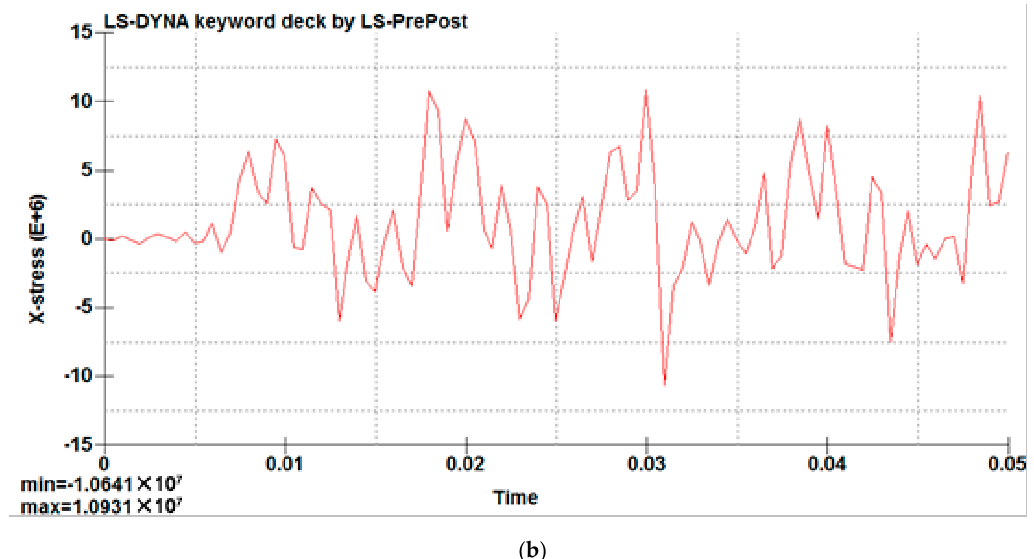
Figure 20. Variation of mid-point stress of welding seam under 100 Hz. ( a ) longitudinal stress. ( b ) transverse stress.